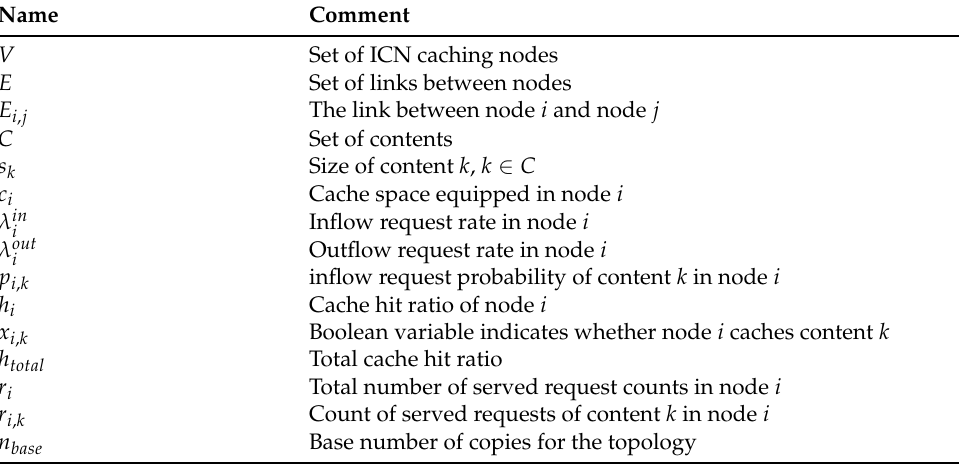
Table 1. Summary of the